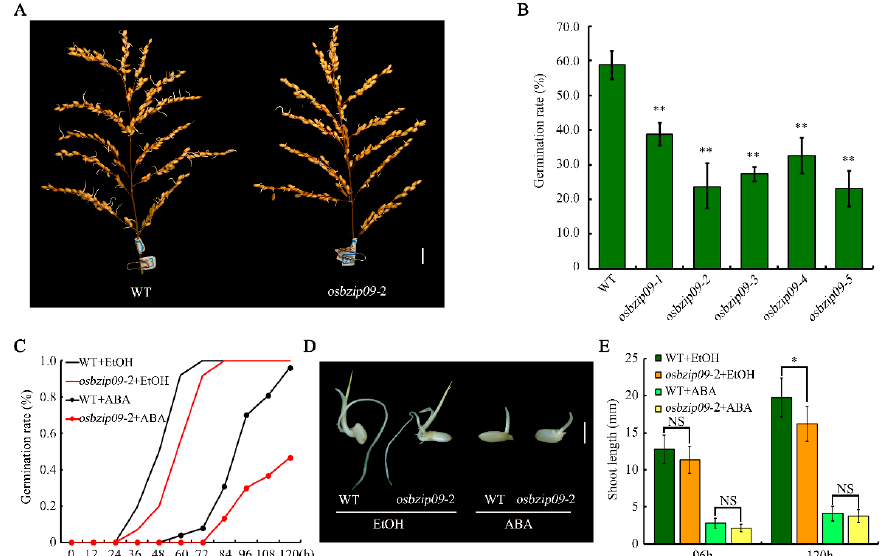
Figure 1. Knock-out of OsbZIP09 inhibits rice pre-harvest sprouting (PHS). Phenotype ( A ) and germination rate ( B ) of mature rice panicles after 6 d imbibition in water. Scale bar, 2 cm. ( C ) Time-course analysis of seed germination under normal conditions. ( D ) Morphology of germinated seeds 96 h after imbibition (HAI). Scale bar, 0.5 cm. ( E ) Shoot length of germinated seeds 96 and 120 HAI. * p < 0.05, ** p < 0.01 ( t -test); NS: not significant.